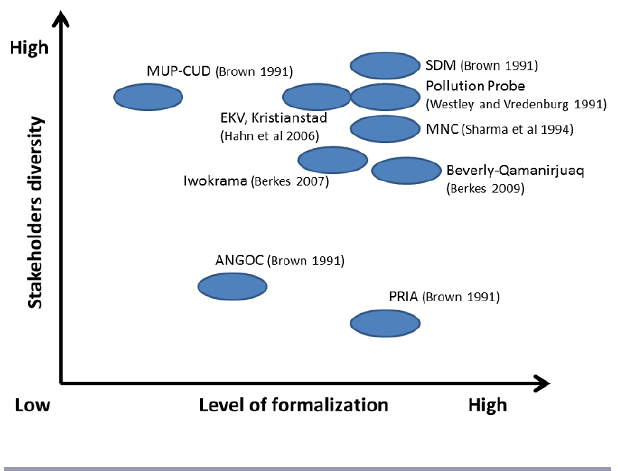
Fig. 1 . Range in forms of bridging organizations based on stakeholder diversity and level of formalization. Stakeholder diversity refers to the heterogeneity of constituents of a bridging organization, as defined by Brown (1991). This categorization is rough and the placement of each organization in the two-dimensional space should be seen as approximate. More work is needed to develop an exhaustive typology of bridging organizations and to fully conceptualize axes along which they